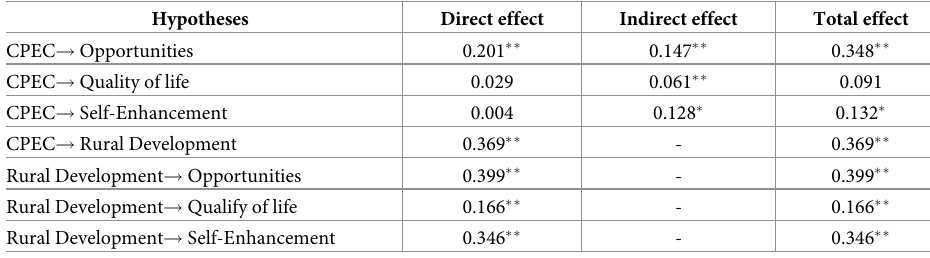
Table 5. Testing